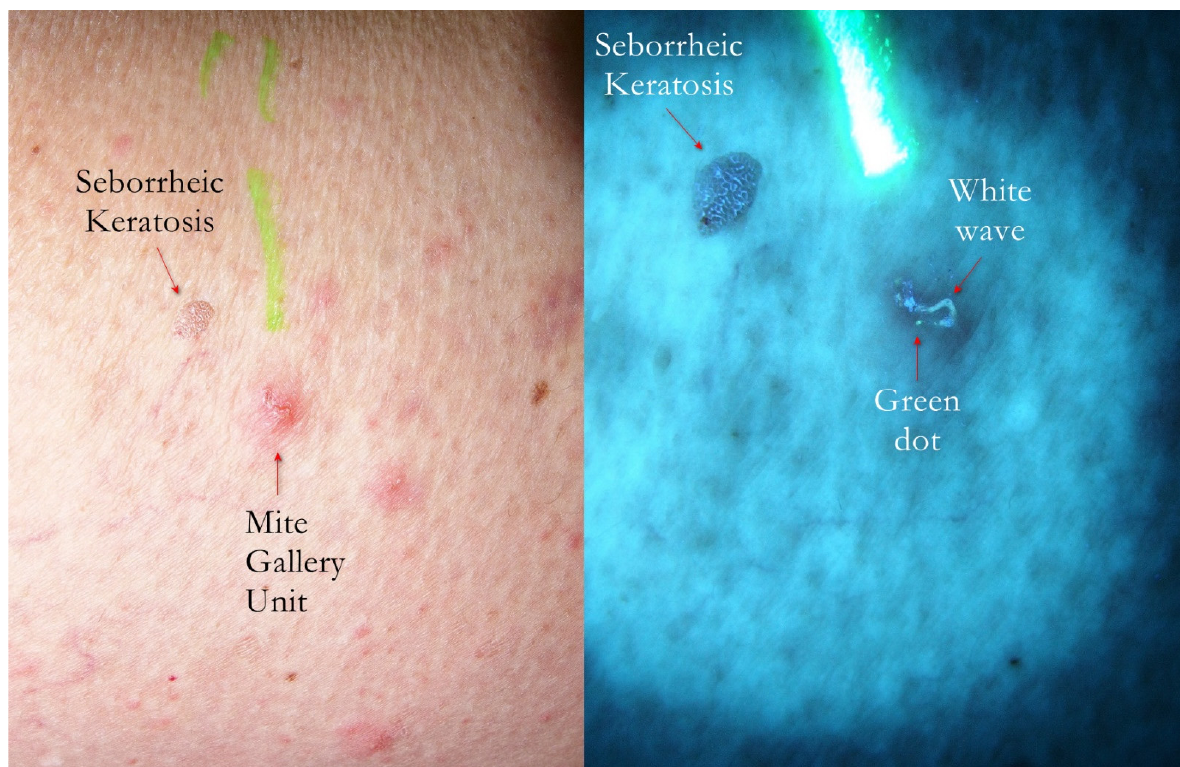
Figure 9. Flash light vs. UVA. A little erythematous area on which a fuzzy linear lesion appeared to the naked eye ( left ). UVA light highlighted the undulated line that corresponded to a MGU whose one extremity ended with a green dot where Sarcoptes was located. A yellow highlighter was used.